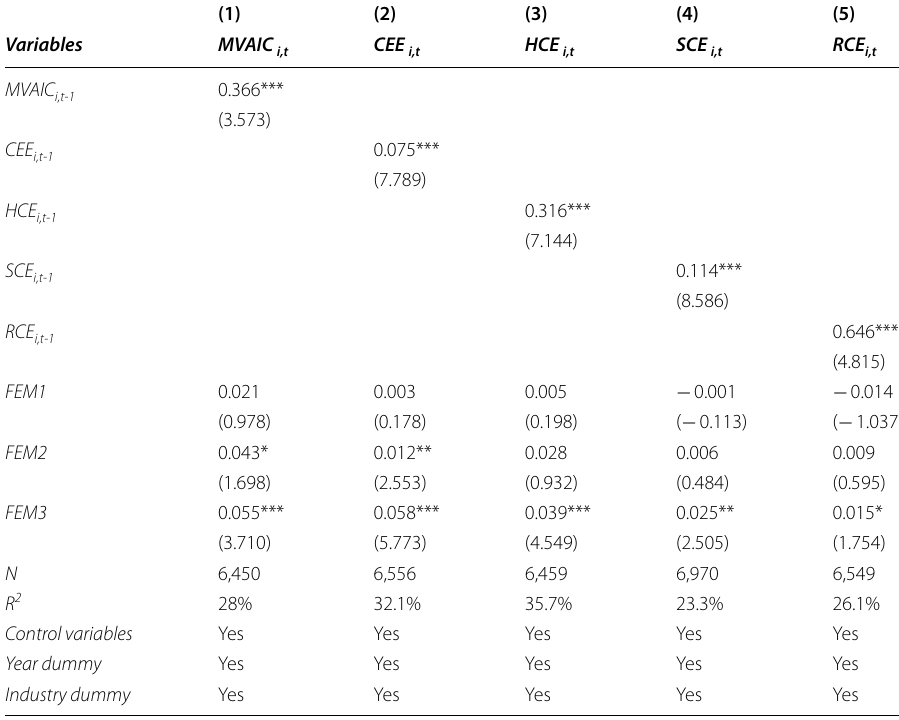
Table 6 Regression results with a lag of dependent